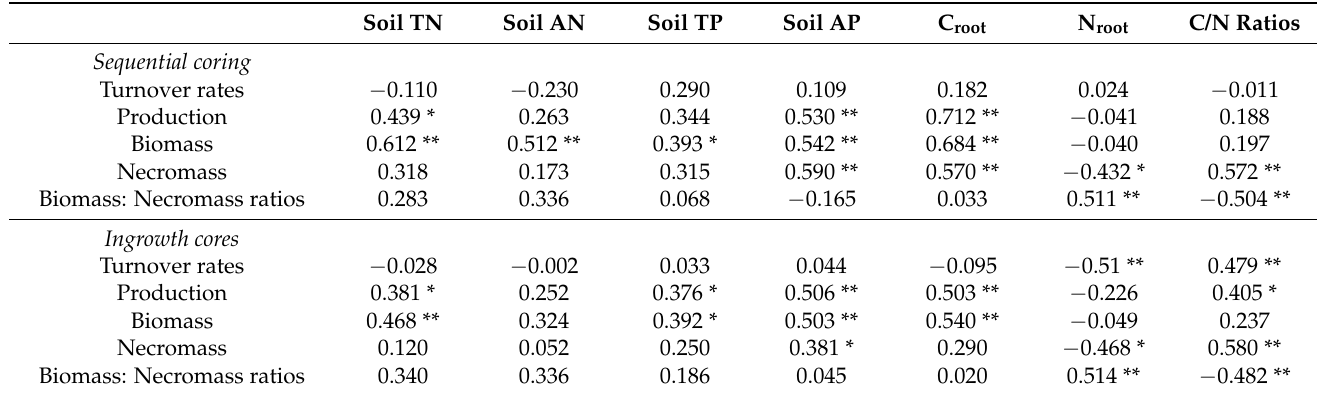
Table 6. Relationships between the characteristics of fine roots and soils.